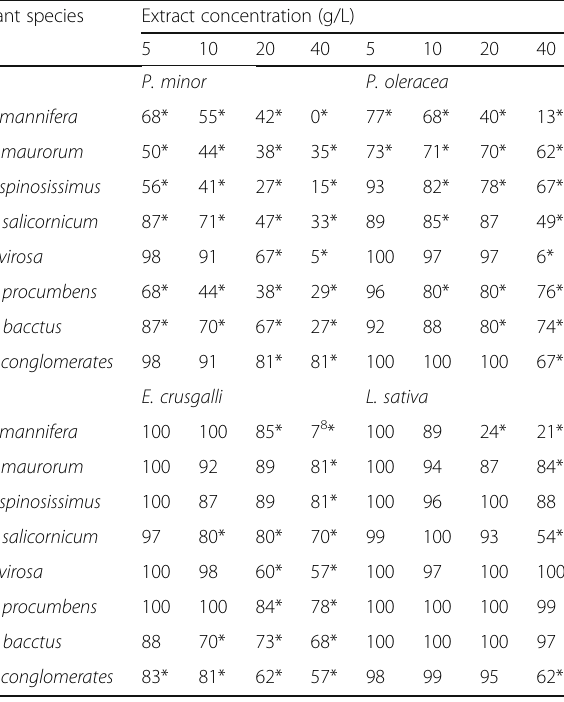
Table 3 Effect of plant extracts (% of control) on root length